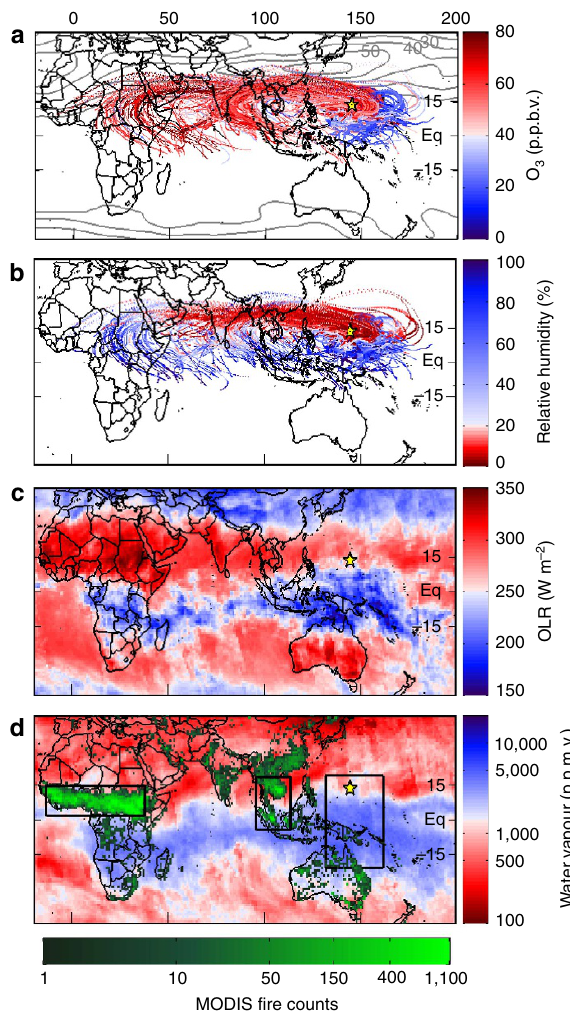
Figure 4 | Origins of air in the TWP. ( a ) 10-day, HYSPLIT back trajectories for all CAST flights analysed here and CONTRAST RF03–05 and RF07–14 for observed pressures between 300 and 700hPa. Trajectories are stopped when encountering convective precipitation and coloured by observed O 3 . For clarity, only every third is shown. Contours are zonal winds at 200hPa averaged over January and February 2014 in 10ms (cid:2) 1 intervals. The yellow star shows Guam. b Same as a but coloured by HYSPLIT RH along the trajectory (see methods). ( c ) AIRS daytime OLR averaged over CAST and CONTRAST flight days. d Same as c but for AIRS H 2 O at 500hPa. MODIS fire counts are the total for January and February 2014. Black rectangles represent the African and Southeast Asian tropical biomass burning regions (determined subjectively by the high fire counts) and the CAST/ CONTRAST study